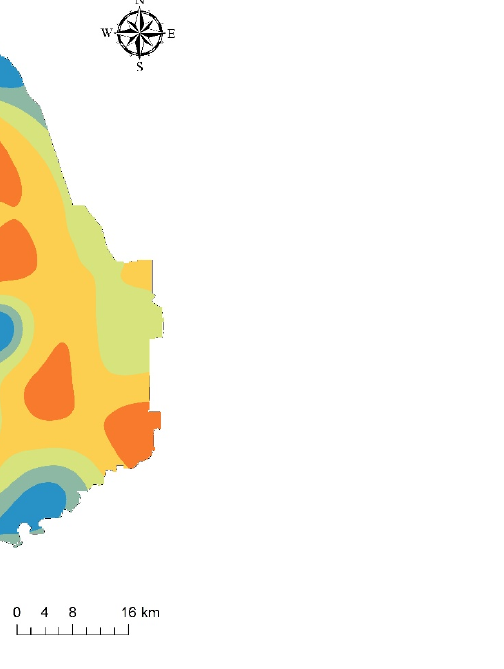
Figure 19. Spatial distribution map of the rainfall impacts on the groundwater level in the Gnangara Figure 19. region.